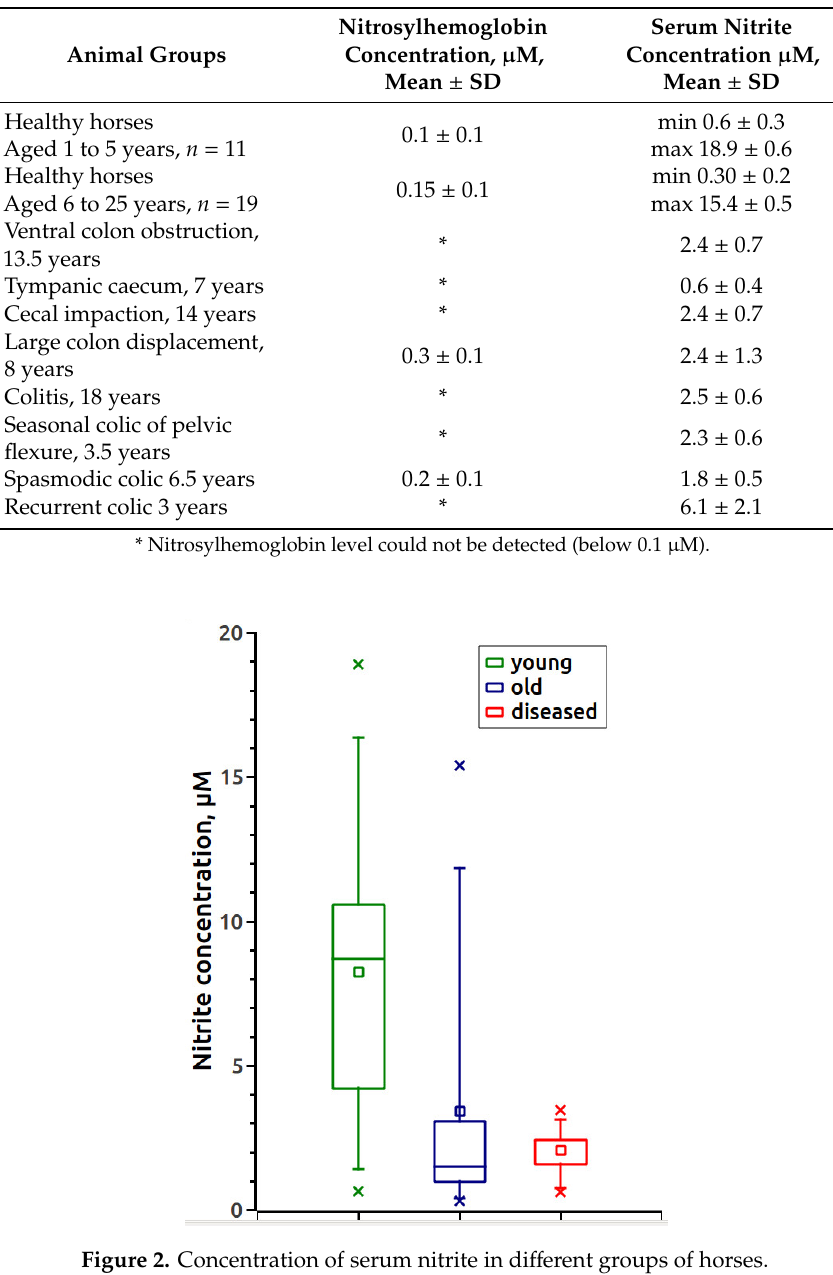
Table 1. Concentration of nitrite in serum and nitrosylhemoglobin HbNO in whole horse blood.